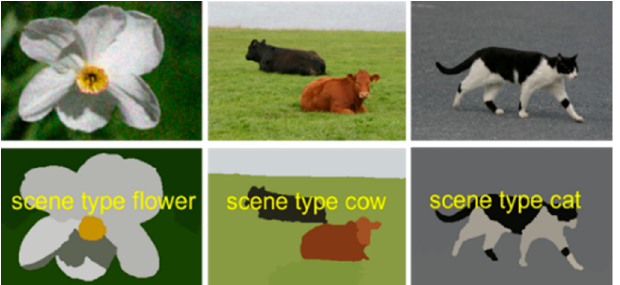
Figure 11. Some examples of object classification in outdoor scenes using the McLR algorithm over the MSRC object dataset.